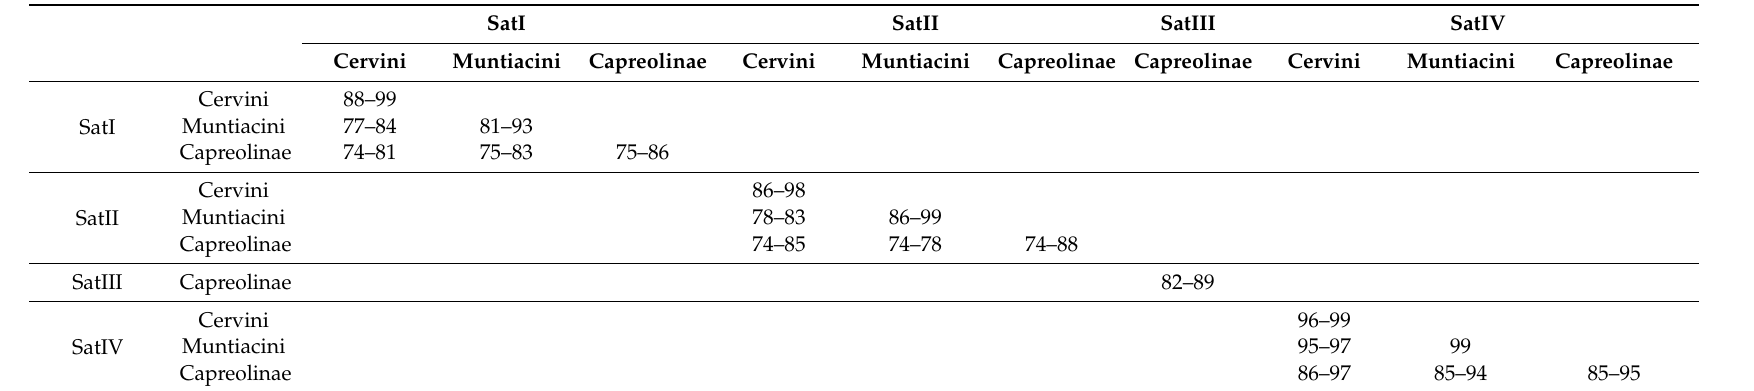
Table 3. Satellite DNA sequence similarity among Cervini, Muntiacini, and